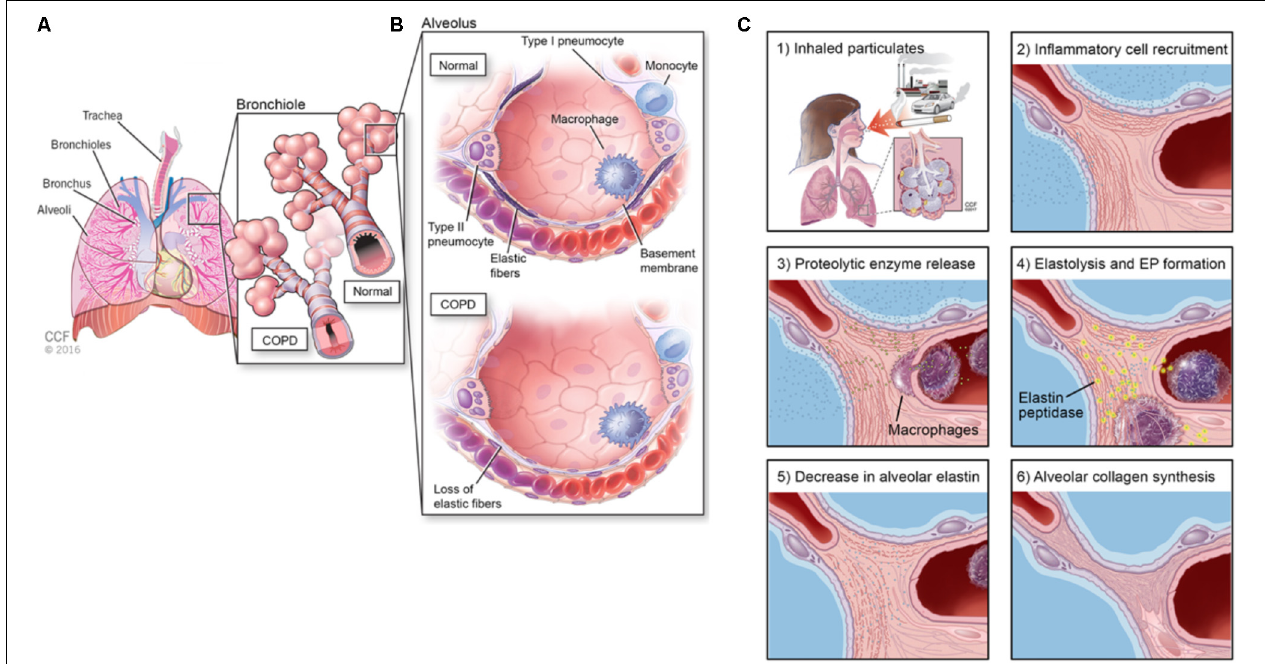
FIGURE 1 | (A) Schematic showing anatomy of the lung, (B) alveolar changes in COPD and airway obstruction ( < 2 mm) diameter in the smaller conducting airways correlates with and is deemed a measure of COPD severity, and (C) etiology of alveolar elastic matrix breakdown following inhalation of particulates. TABLE 2 | Sampling of COPD Drugs in development over the last 15 years (Yasothan and Kar, 2008; Mushtaq, 2014). Company Drug Mechanism Development phase AstraZeneca AZD-1236/9668/4818 Anti-inflammatory Phase I BAY-71-9678 Elastase Inhibitor Phase